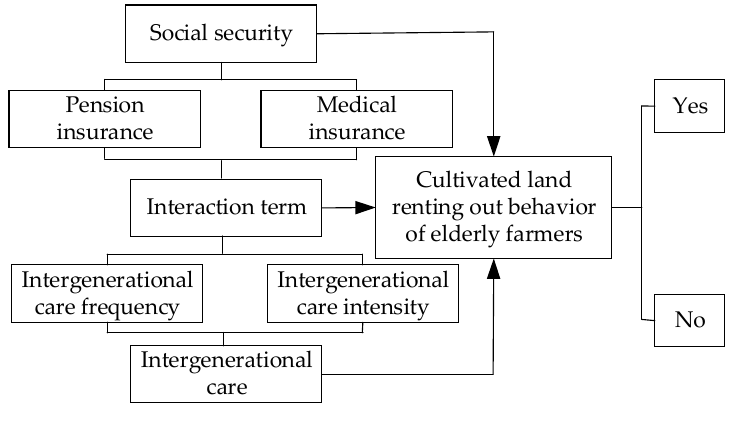
Figure 1. Analytical framework.